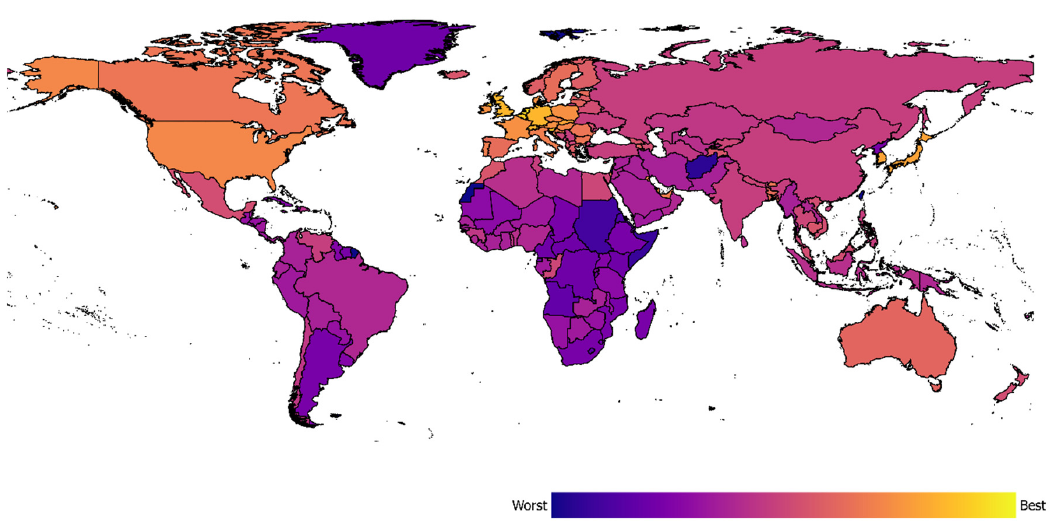
Figure 7. Global view on the location dimension.